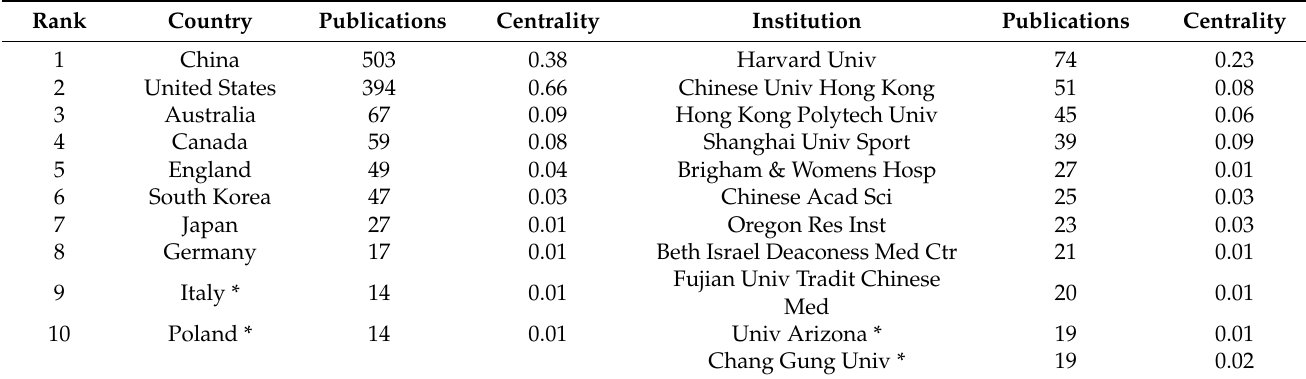
Table 1. Ranking of top 10 countries and institutions in the field of Tai Chi research from 1980 to 2020.